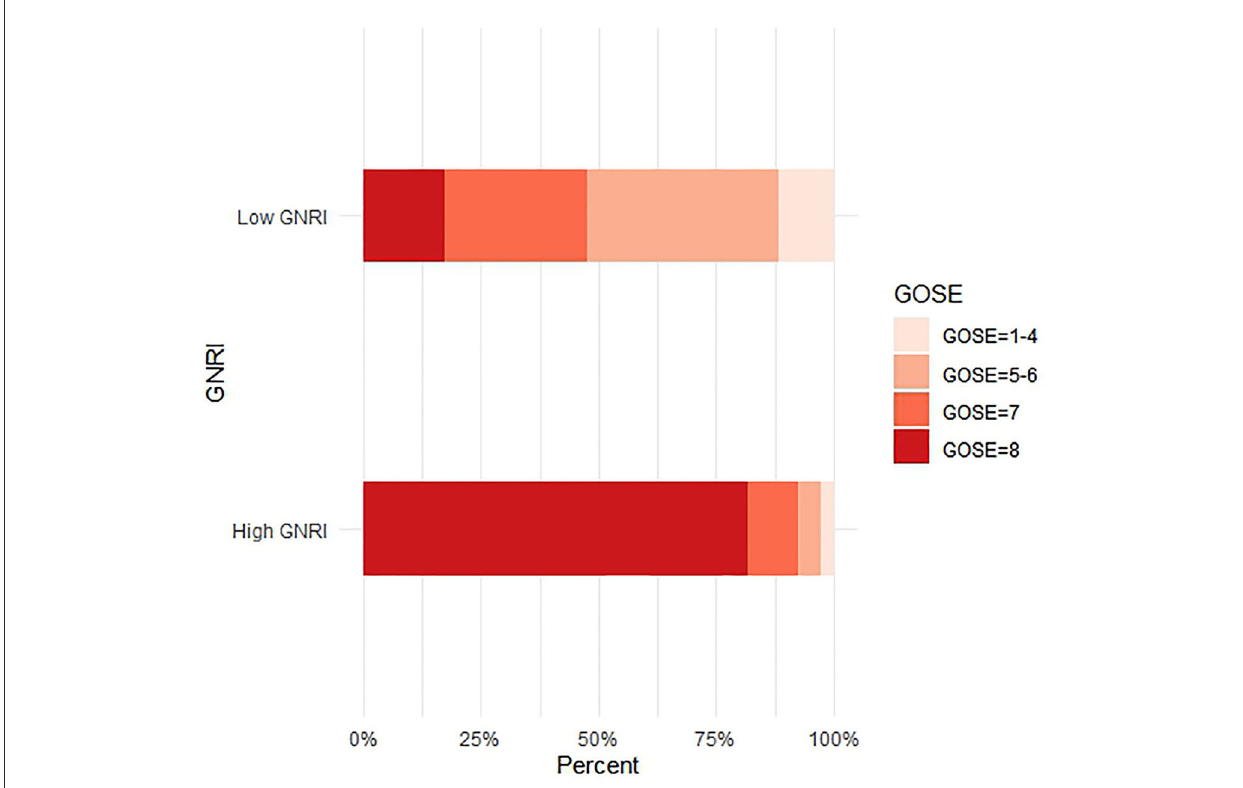
FIGURE3 The primary outcome measure was assessed with the use of the GOSE, an outcome scale assessing functional independence, work, social and leisure activities, and personal relationships. The eight outcome categories are death (GOSE = 1), vegetative state (GOSE = 2), lower severe disability (GOSE = 3), upper severe disability (GOSE = 4), lower moderate disability (GOSE = 5), upper moderate disability (GOSE = 6), lower good recovery (GOSE = 7), and upper good recovery (GOSE =